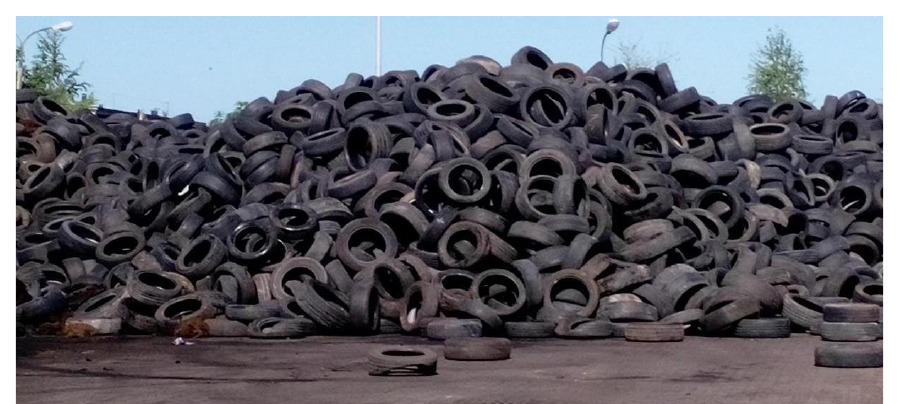
Figure 3. Tires stored in the case study company. Source: Photo taken during the